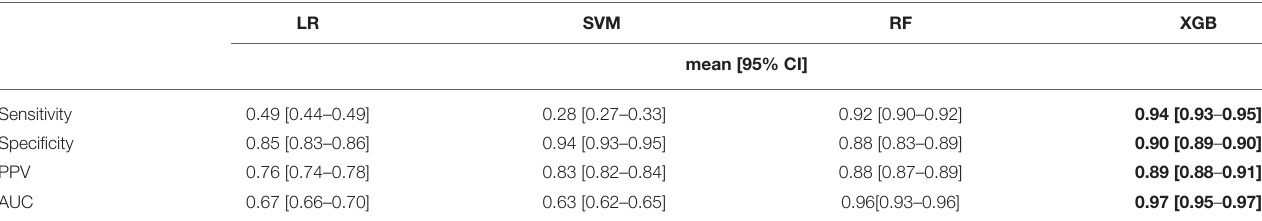
TABLE 2 | Comparison of model